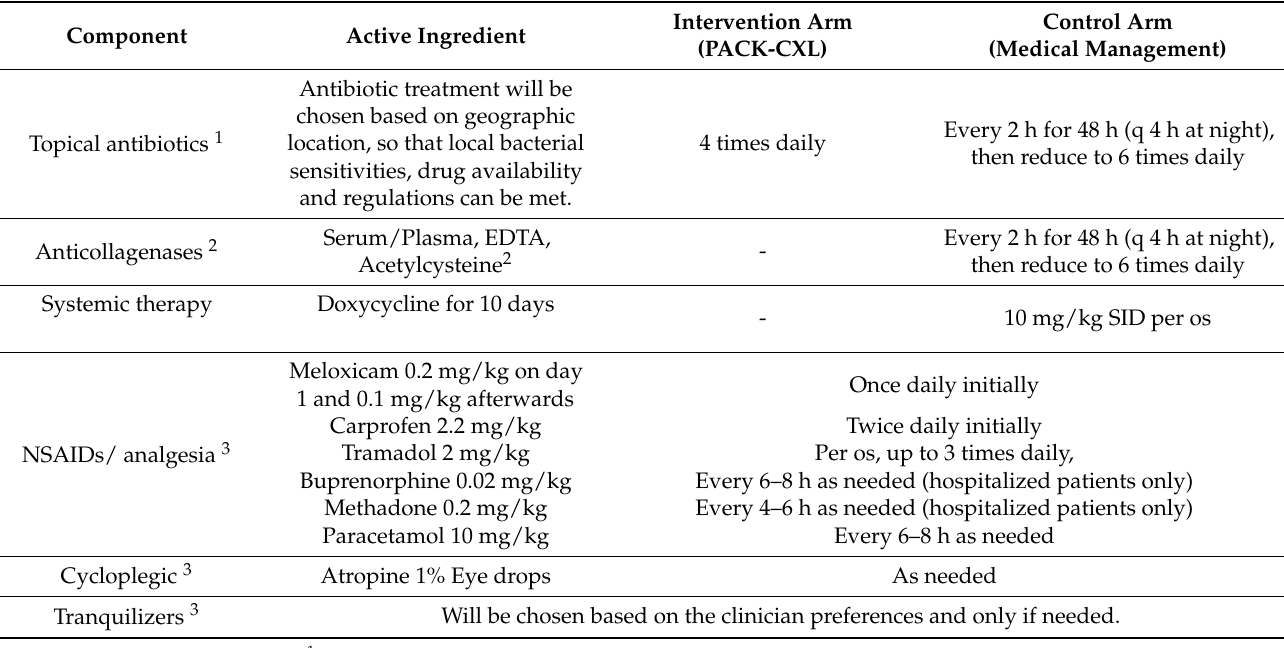
Table 1. Medical treatment frequency and